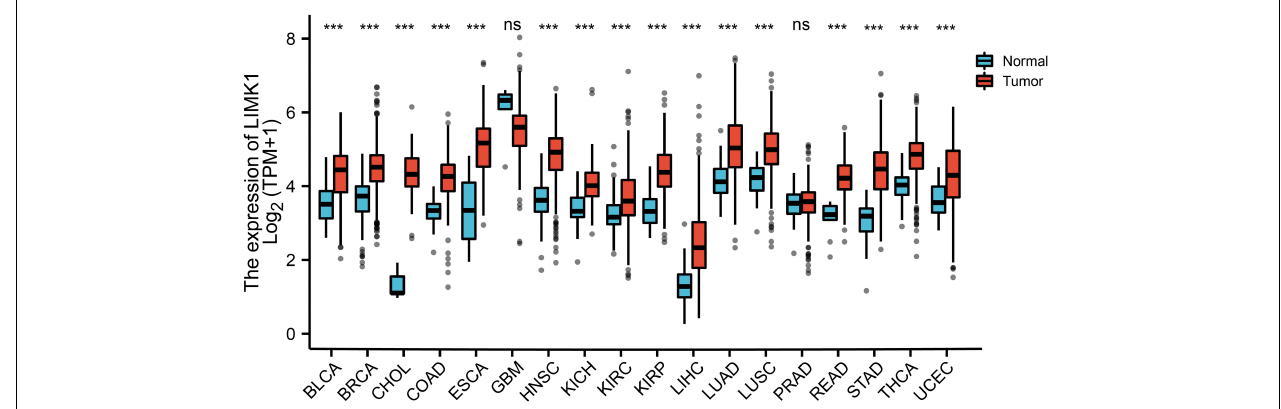
FIGURE 1 | Expression pattern of LIMK1 in Pan-cancer perspective. The mRNA expression of LIMK1 was upregulated in 16 of 18 cancer types compared with normal tissues. (*** P < 0.001). ns, no significance; BLCA, bladder urothelial carcinoma; BRCA, breast invasive carcinoma; CHOL, cholangiocarcinoma; COAD, colon adenocarcinoma; ESCA, esophageal carcinoma; GBM, glioblastoma mutiforme; HNSC, head and neck squamous cell carcinoma; KICH, kidney chromophobe; KIRC, kidney renal clear cell carcinoma; KIRP, kidney renal papillary cell carcinoma; LIHC, liver hepatocellular carcinoma; LUAD, lung adenocarcinoma; LUSC, lung squamous cell carcinoma; PRAD, prostate adenocarcinoma; READ, rectum adenocarcinoma; STAD, stomach adenocarcinoma; THCA, thyroid carcinoma; UCEC, uterine corpus endometrial carcinoma.